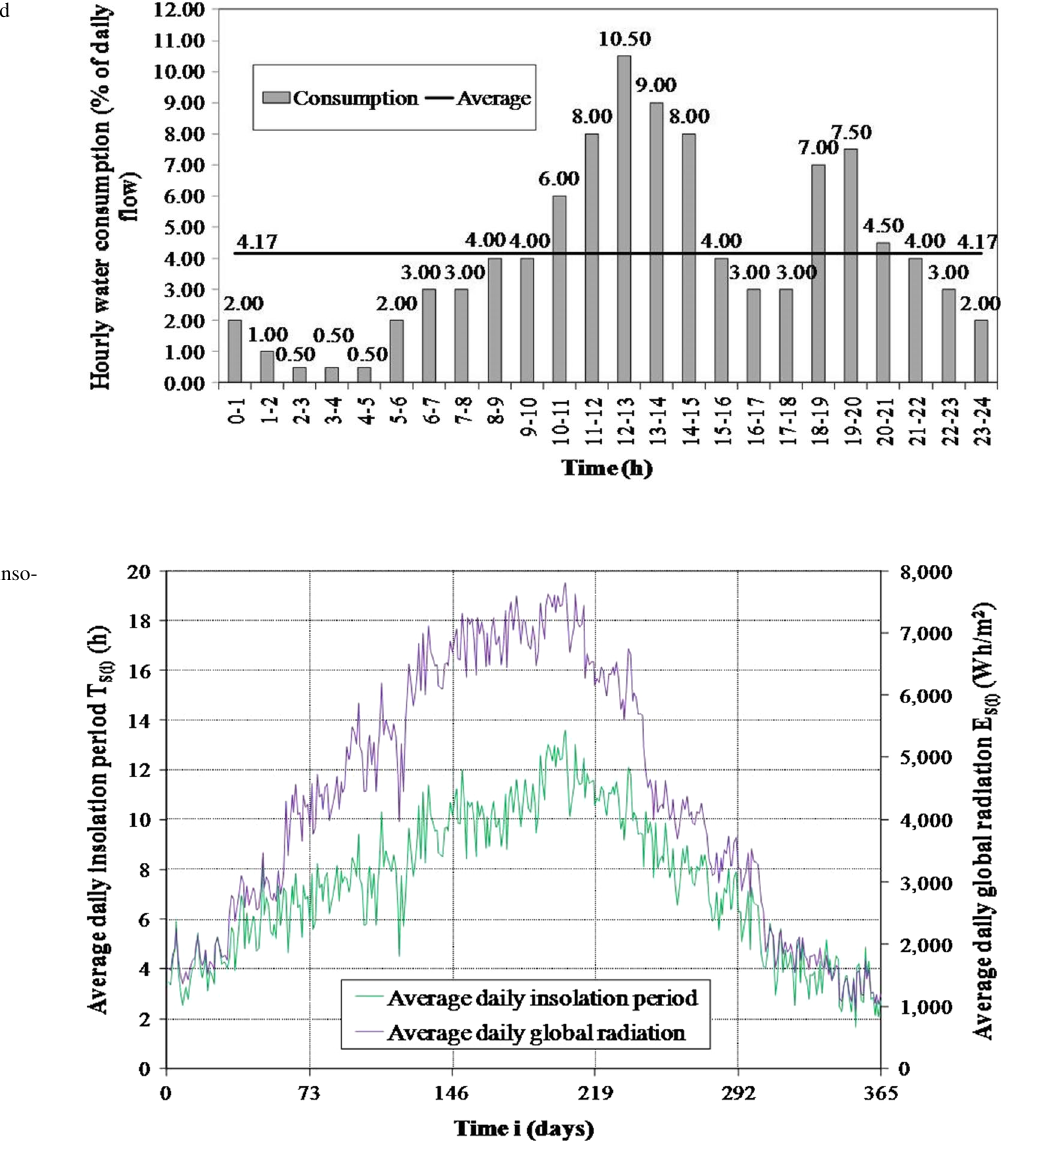
Fig. 5 Hourly water demand during typical day